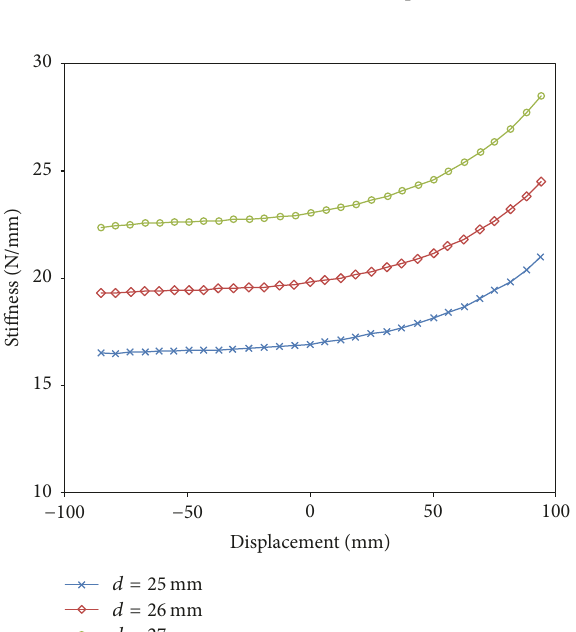
Figure 5: Stiffness curve of the suspension.